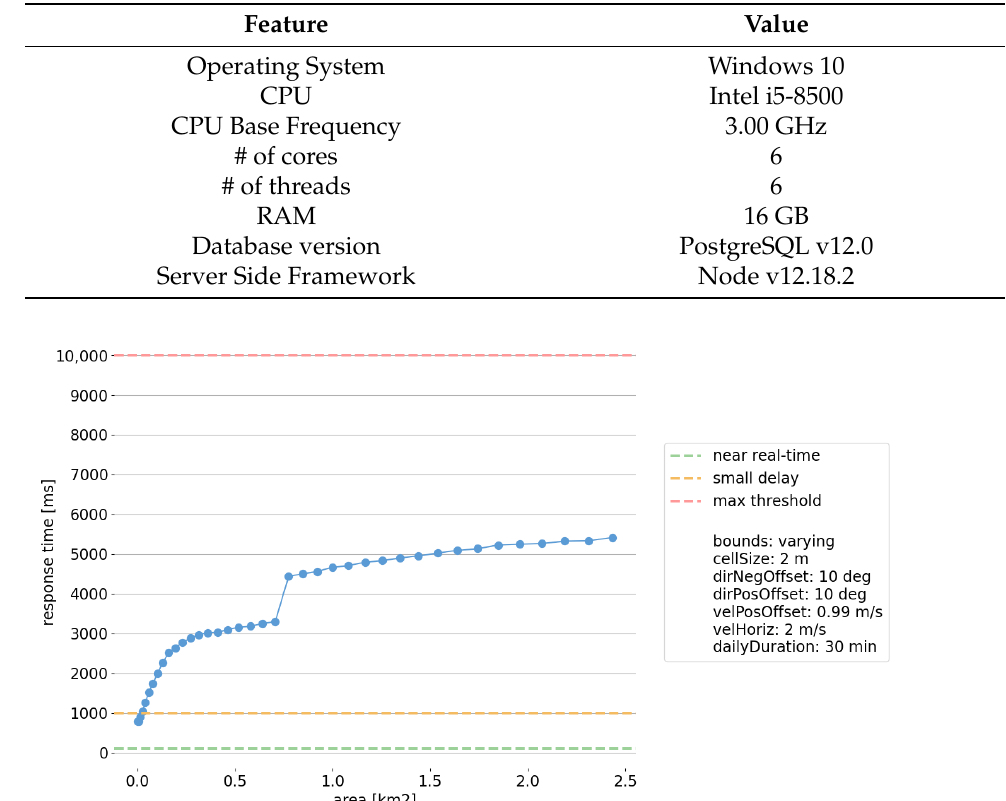
Table 5. Software and hardware specifications of the testing environment.